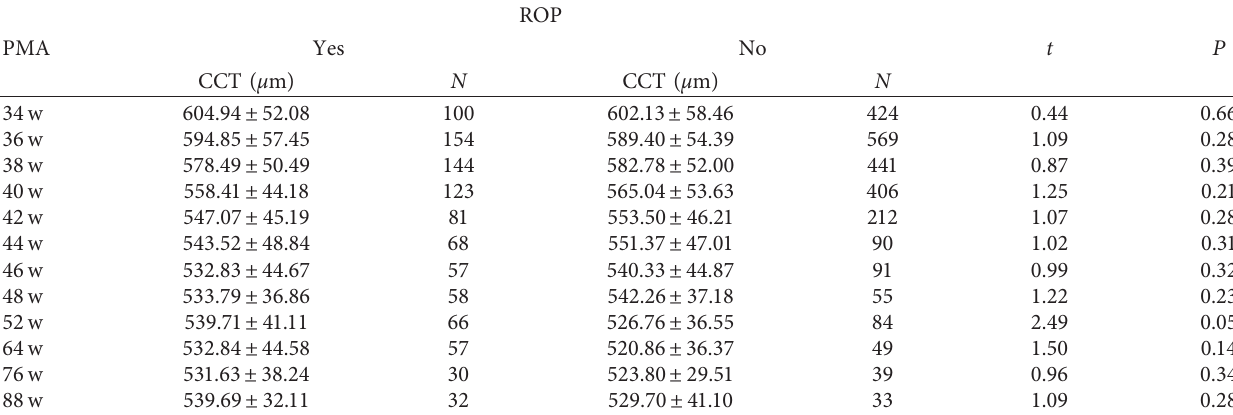
Table 6: Mean CCT in the ROP subgroup and without the ROP subgroup at each